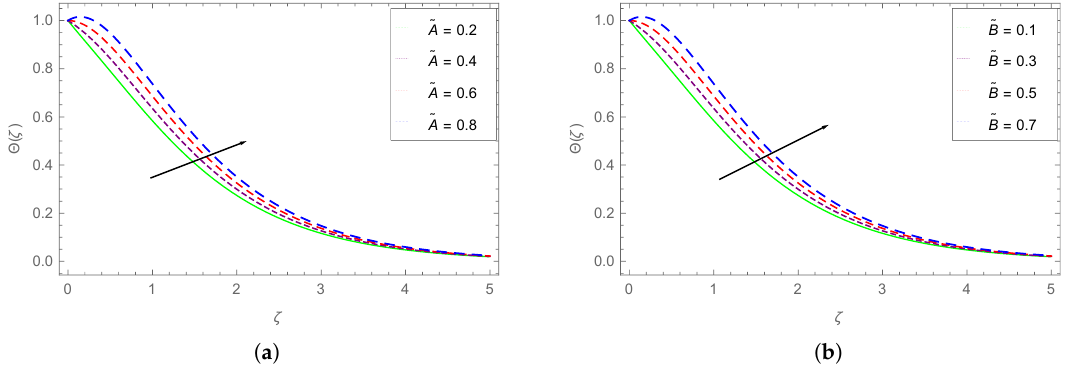
Figure 15. ( a ) Effect of ˜ A on ( θ ( ζ ) ) and ( b ) influence of ˜ B on θ ( ζ ) .